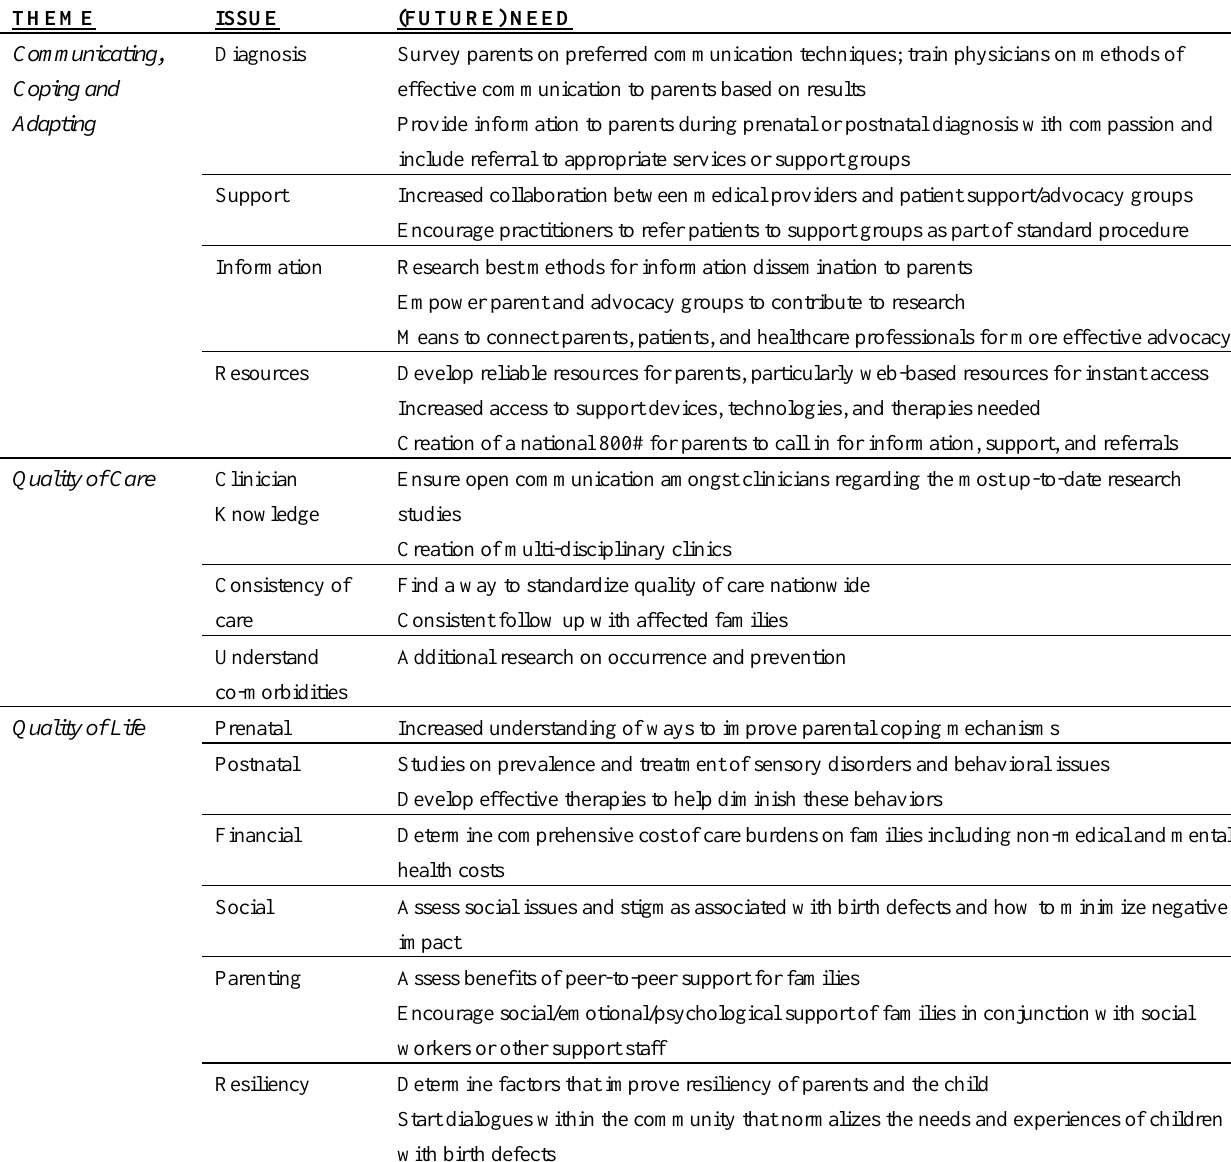
Table 1. Common themes among parents of children with different types of birth